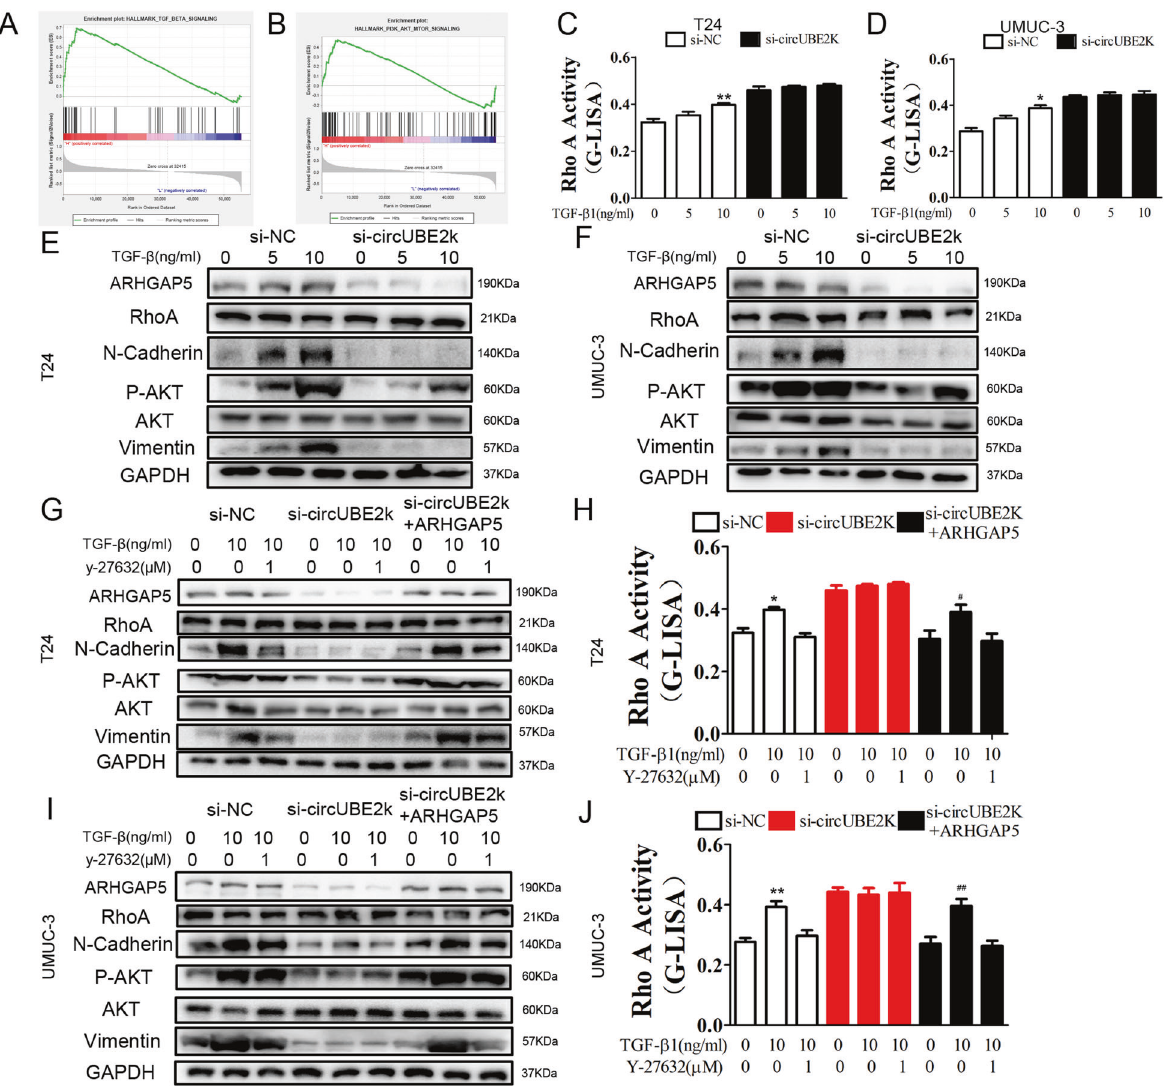
Fig. 7 Silencing circUBE2K increased TGF- β stimulated Rho A activity mediated EMT in bladder cancer cell. TGF β signaling ( A ) and PI3K AKT MTOR signaling ( B ) were signi fi cantly enriched in ARHGAP5 highly expressed bladder cancer samples in TCGA cohort through GSEA. RhoA G-LISA activation assays were used to measure RhoA activity in T24 ( C ) and UM-UC-3 ( D ) treated with different concentrations of TGF- β 1 ( * P < 0.05 versus si-NC). T24 ( E ) and UM-UC-3 ( F ) cells transfected with si-NC and si-circUBE2K were treated with different concentrations of TGF- β 1, of which cell lysates were then subjected to western blot analysis with anti-ARHGAP5, anti-p-AKT, anti-N-Cadherin, anti-Vimentin and anti-GAPDH. T24 ( G ) and UM-UC-3 ( I ) cells were transfected with si-NC, si-circUBE2K, si-circUBE2K + ARHGAP5 and then treated with or without 10 ng/ml TGF- β 1 and 1 µM Y-27632. Cell lysates were then subjected to western blot analysis. Meanwhile, RhoA activity was measured by G-LISA activation assays across T24 ( H ) and UM-UC-3 ( J ) ( ** P < 0.01, * P < 0.05 versus si-NC, ## P < 0.01, # P < 0.05 versus si-circUBE2K + reduced the growth rate and weight of BC tumor, which could be ARHGAP5. Our results, together with previous results indicated rescued via miR-516b-5p inhibition or ARHGAP5 overexpression circUBE2K orchestrate BC progression via circUBE2K/miR-516b-5p/ (Fig. 8A, B). In compliance with our previous fi ndings, IHC analysis ARHGAP5/ RhoA mediated EMT process. revealed that the expression of ARHGAP5, EMT marker (Vimentin and N-Cadherin), cell proliferation marker (Ki-67) was inhibited by silencing circUBE2K and recovered after silencing miR-516b-5p or up-regulation of ARHGAP5 (Fig. 8C). Furthermore, biolumines- cence imaging revealed that silencing circUBE2K reduced metastasis potential of T24 cells (Fig. 8D). In line with the micropathological results, hematoxylin and eosin-stained tissues showed that sh-circUBE2K-T24 cells formed up fewer nodules and smaller lesion areas in the lungs, which miR-516b-5p inhibition or ARHGAP5 overexpression could partially recover the metastasis ability of T24 cells (Fig. 8E). subcutaneously and measured. circUBE2K knockdown signi fi cantly